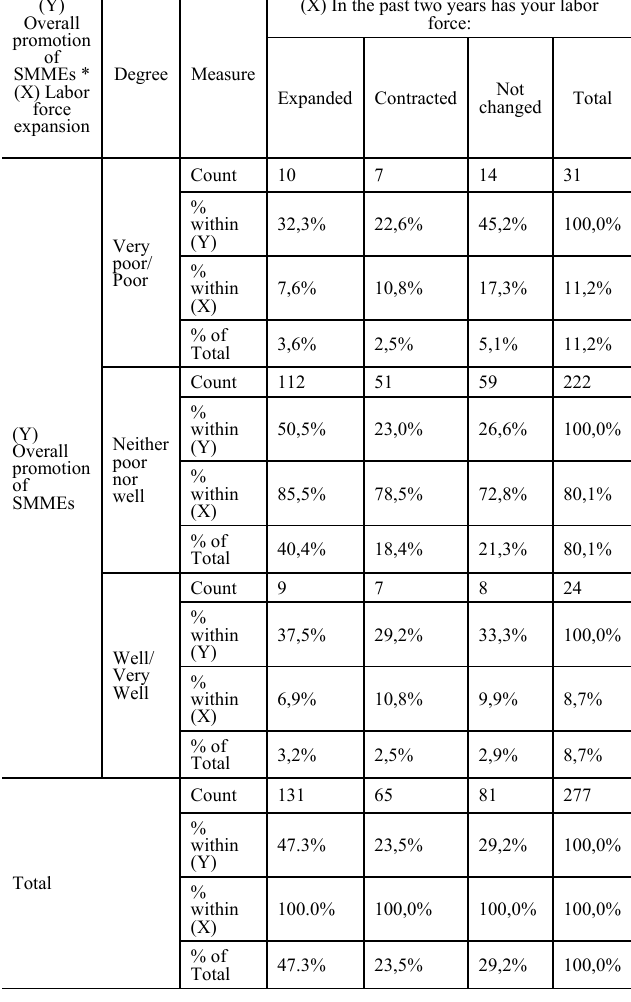
Table 11b: Chi-square test